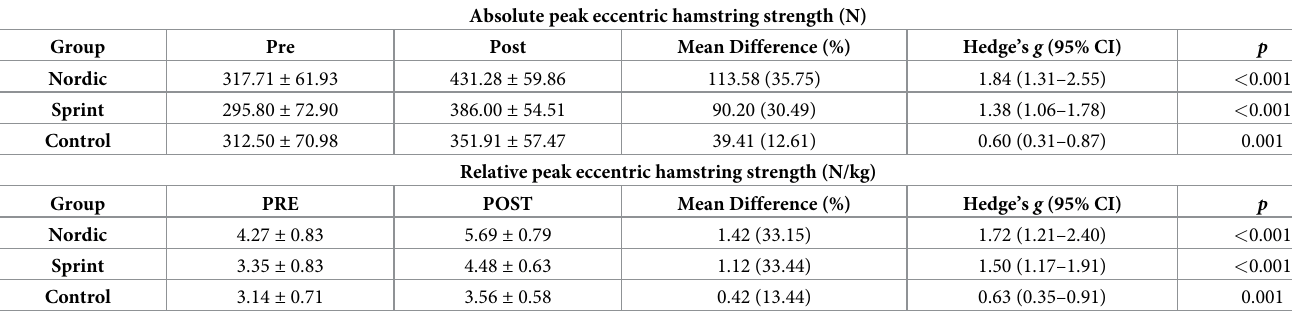
Table 6. Pairwise comparisons of eccentric hamstring measures for all training